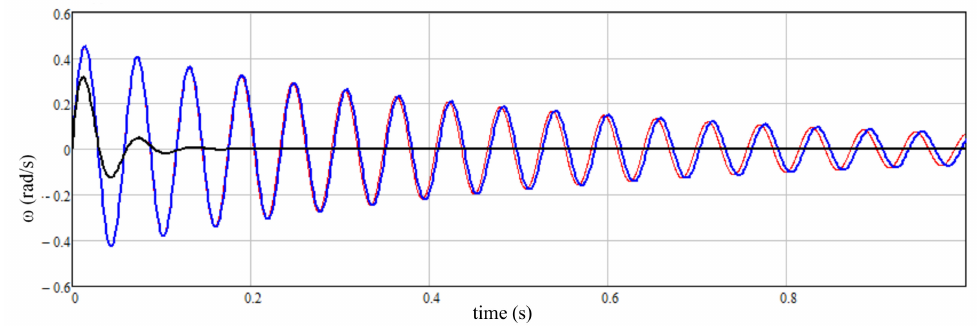
Figure 7. Speed dependencies: __ model with distributed parameters; __ traditional model of a two-mass system; __ model of a two-mass system using the Caputo–Fabrizio operator to describe of the fractional order derivative in the model of the elastic moment at α = 0.995.